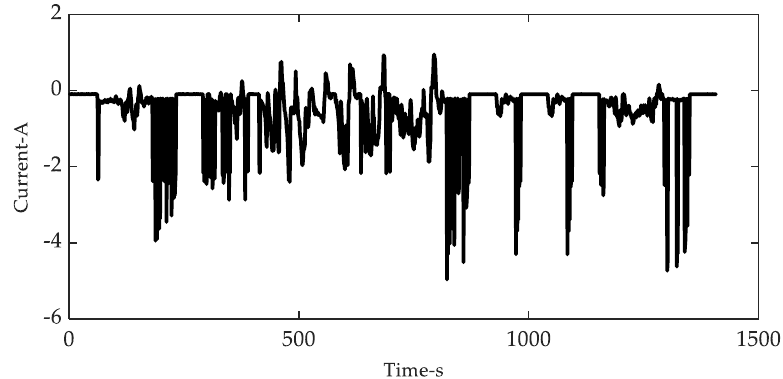
Figure 5. The measured data points and fitted curve of SOC versus OCV.